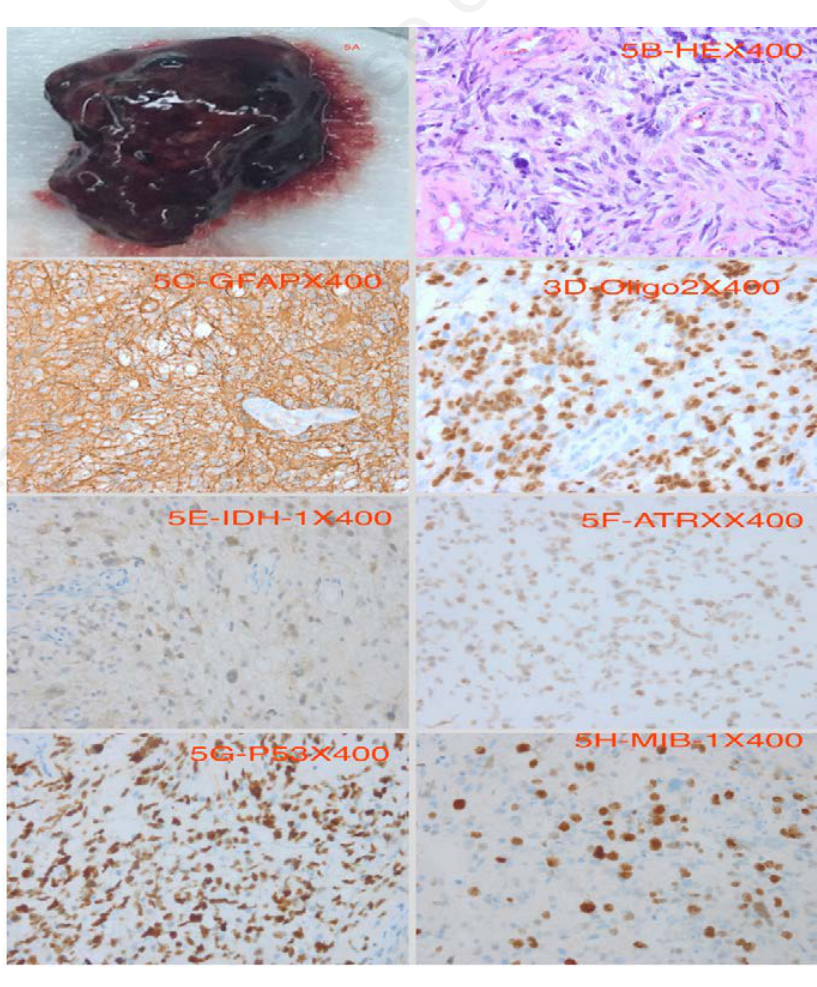
Figure 5. Pathological images. A) Is the evacuated hematoma, while B-H) are images of varies immunohistochemical staining. B) HE 400×, C) GFAP 400×, D) Oligo2 400×,